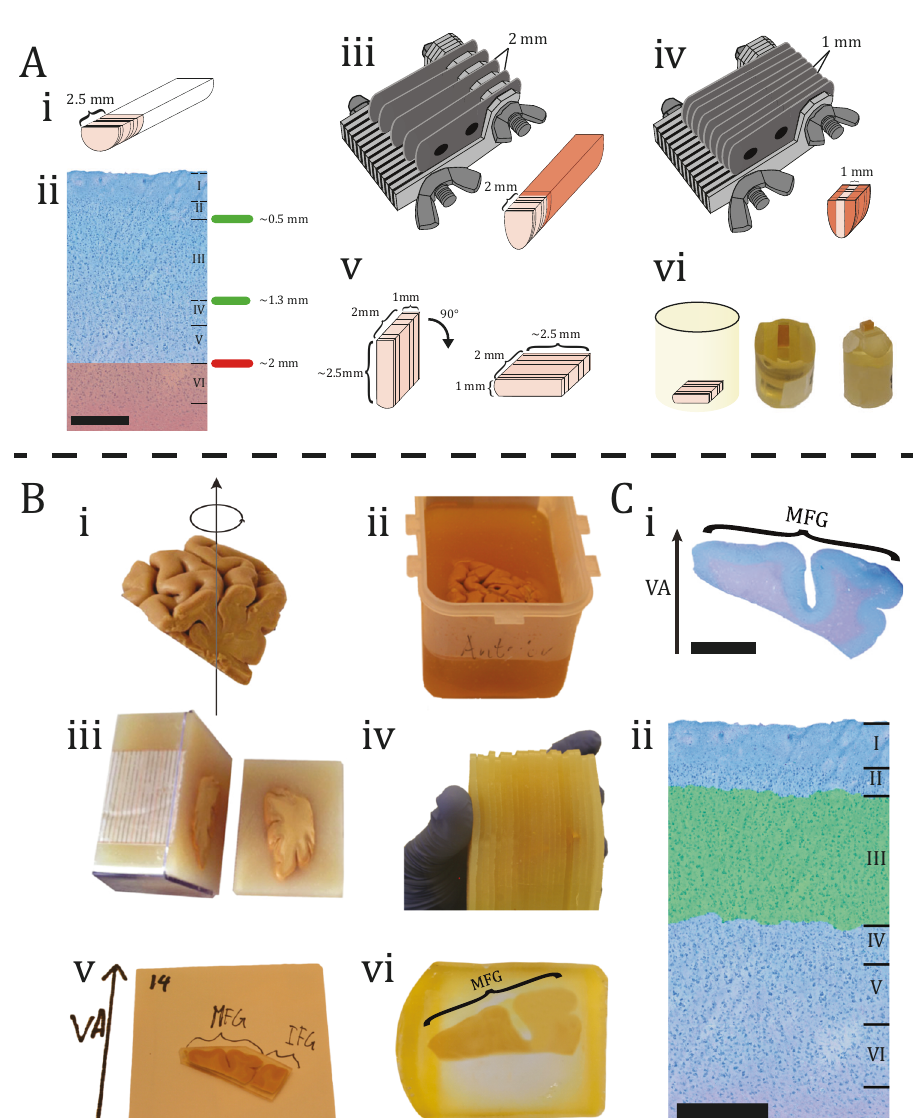
Fig. 1 Sample preparation. A Biopsy preparation of the laminar site of the biopsy from BA46 is depicted in this illustration, with an average height of 2.5 mm (i). The six layers of BA46 can be seen in a cross-section of a biopsy after it has been stained with toluidine blue. Scale bar = 500 µm. Layer III is located within 2 mm of the pial surface (ii). A razor knife with a 2 mm gap between each blade was fl ipped on top of the biopsy. The red area shows the removed tissue (iii). A razor knife with a 1 mm gap between each blade was fl ipped on top of the biopsy. The red area shows the removed tissue (iv). The dimension of the tissue can be seen after the excess tissue has been removed. Before inserting the tissue within the embedding mold, it was fl ipped 90 ◦ to make sure the layers were parallel to the cutting direction (v). The illustration shows the tissue in the embedding mold. The resin block was photographed after it was trimmed with a glass knife, so it only contained layers I – IV (vi). B Tissue block preparation of DLPFC containing BA46 was rotated uniformly around a vertical axis (VA), perpendicular to the block ’ s central pial surface (i). The tissue block was embedded in a box fi lled with 7% agarose (ii). Next, the tissue block was cut systematically into uniformly random into 2.5 mm slabs orthogonal to the anterior-posterior direction (iii). The tissue block was then reassembled and every second the slab was systematically sampled (iv). After that, each slab was documented and various gyri positions were speci fi ed, e.g., medial frontal gyrus (MFG), inferior frontal gyrus (IFG) (v). Finally, the slabs were embedded in glycolmethacrylate (vi). C The section were stained with toluidine blue and VA was positioned based on documentation. Scale bar = 6 mm (i). The stereological analysis was then performed in layer III of BA46 based on the cytoarchitecture. Scale bar = 500 µm bottom of the box, a paper ruler was placed, and the tissue block was rotated around the VA before being embedded in 7% agarose. After the hardening of the agarose, the block was cut into uniform random 2.5 mm thick parallel vertical slabs perpendicular to the anterior-posterior position using the Systematic Uniform Random Sampling procedure. The VA and neuroanatomy markers of each slab were then delineated, numbered, and documented. Following that, each slab was subsequently embedded in glycolmethacrylate (Technovit 7100) and cut into 40 µm sections, dyed with a Toluidinblue-Borax Solution and mounted with Eukitt.